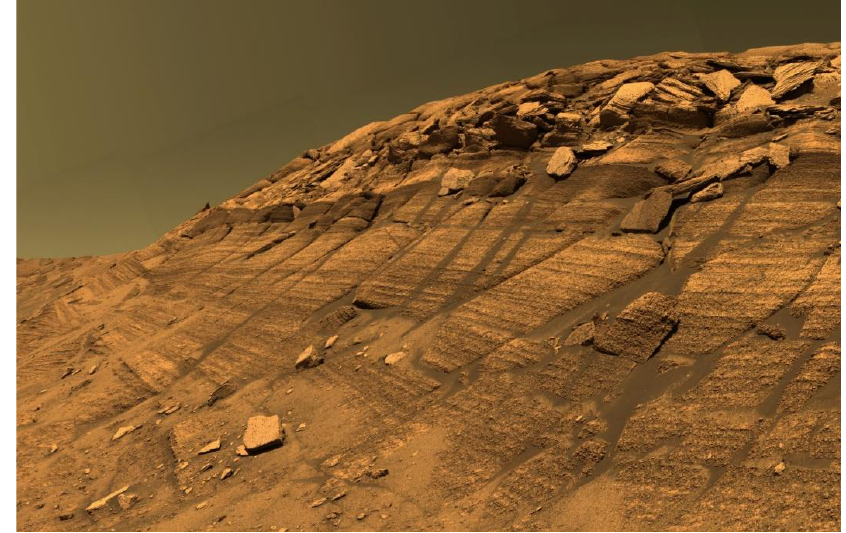
Figure 7. The preservation and cementation of aeolian dune stratigraphy in Burns Cliff in Endurance Crater are thought to have been controlled by the flow of shallow groundwater [129].